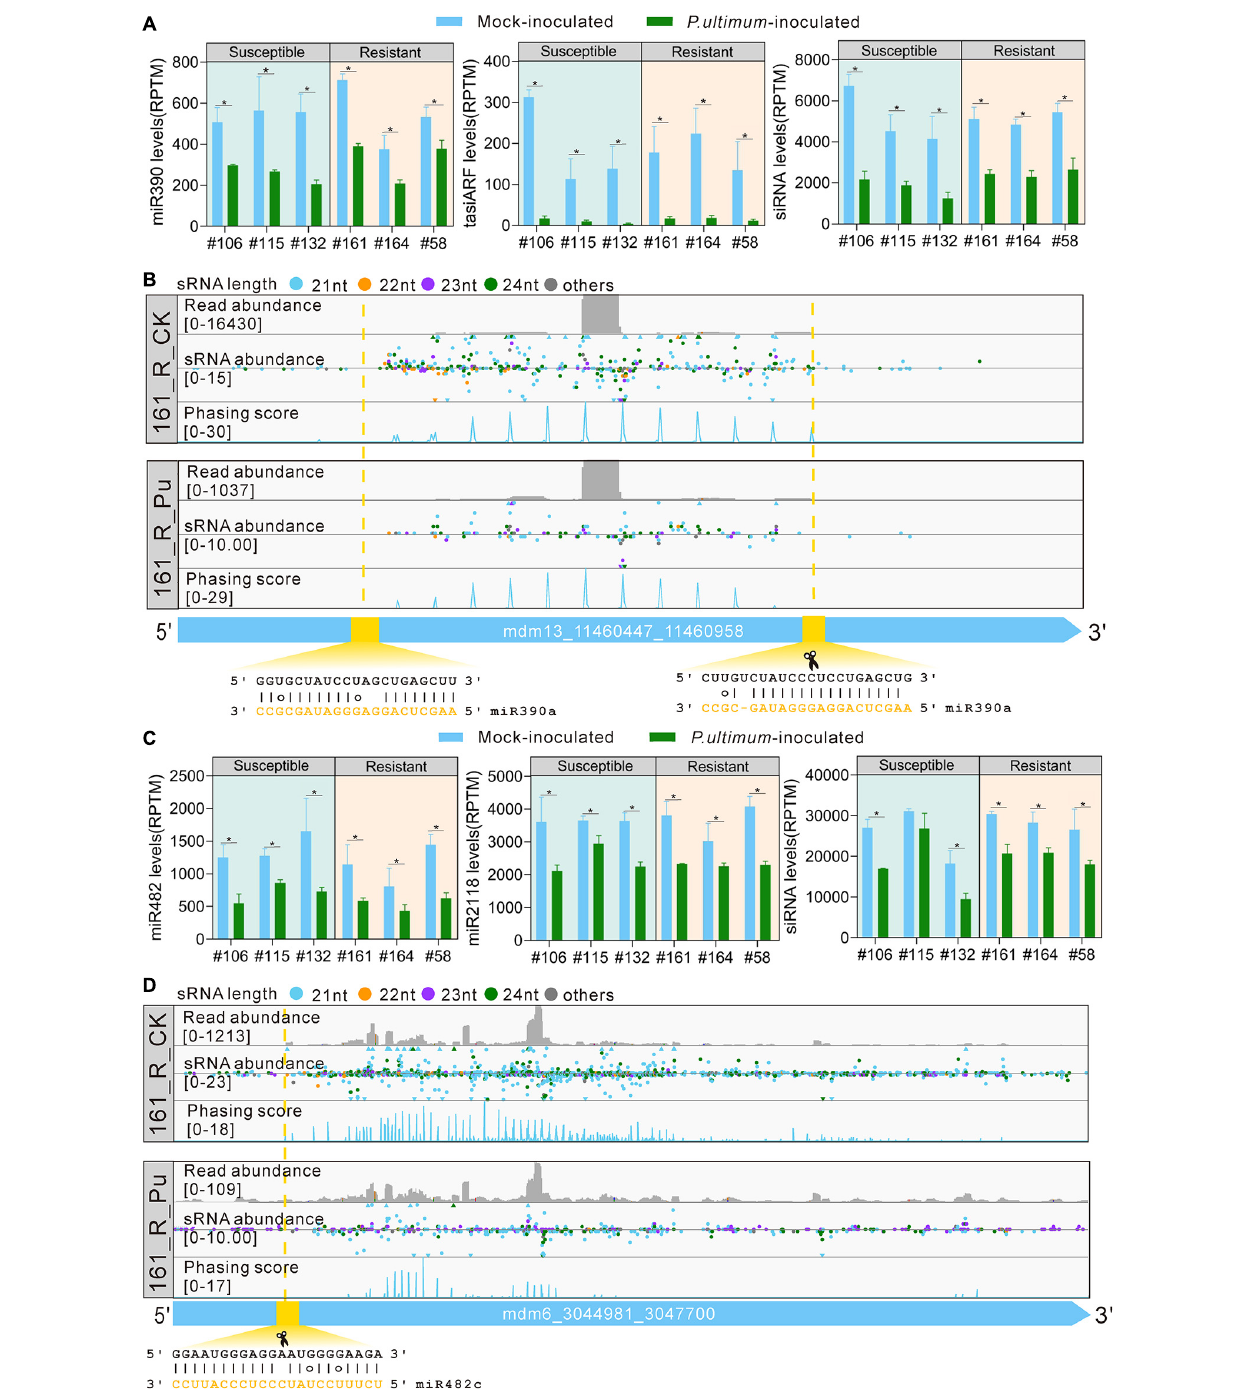
FIGURE 5 | miRNA triggers phasiRNA biogenesis in response to P. ultimum inoculation. (A) The expression levels of miR390, tasiARF, and siRNA from TAS3 transcripts in mock-inoculated (blue bars) and P. ultimum -inoculated (green bars) root issues. (B) Read abundance, sRNA abundance and phasing score distribution of a TAS3 locus in mock-inoculated and P. ultimum -inoculated root issues were viewed in IGV-sRNA. The yellow dashed lines and rectangle indicate the target site and slicing site of miR390a. (C) The expression levels of miR482, miR2118, and siRNA from NBS-LRR transcripts (HF37161) in mock-inoculated (blue bars) and P. ultimum -inoculated (green bars) root tissues. (D) Read abundance, sRNA abundance, and phasing score distribution of a representative PHAS locus in mock-inoculated and P. ultimum -inoculated root tissues were viewed in IGV-sRNA. The yellow dashed lines and rectangle indicate the target site of miR482c. Phasing score was calculated based on the mapping results of 21-nucleotide siRNAs (Xia et al., 2013). Error bars represent SE of three independent biological replicates. Asterisks denote statistically significant differences in a one-tailed Mann–Whitney U test (* P < 0.05).